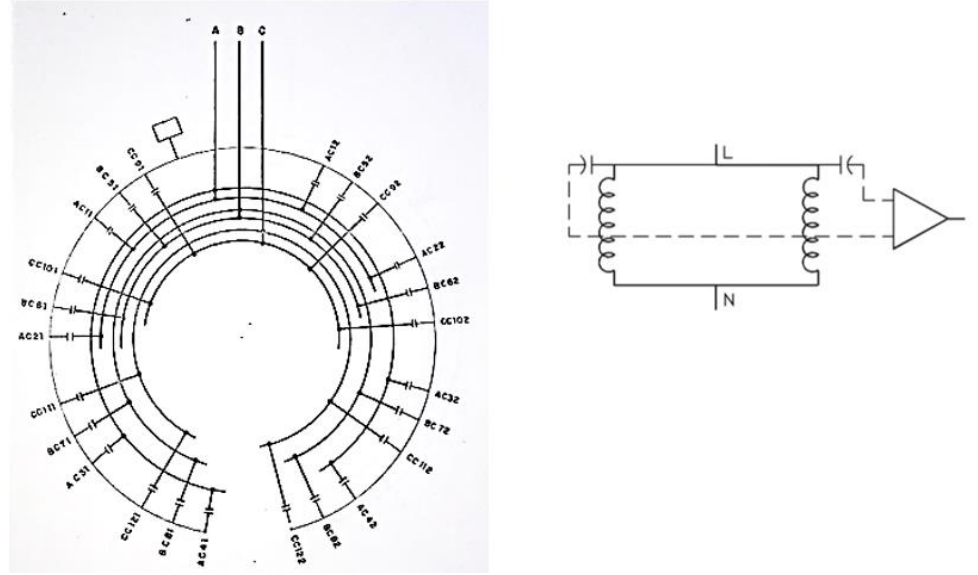
Figure 2. Coupler installation model along the stator and schematic drawing of the IEEE 1434-2014 standard [21,25].